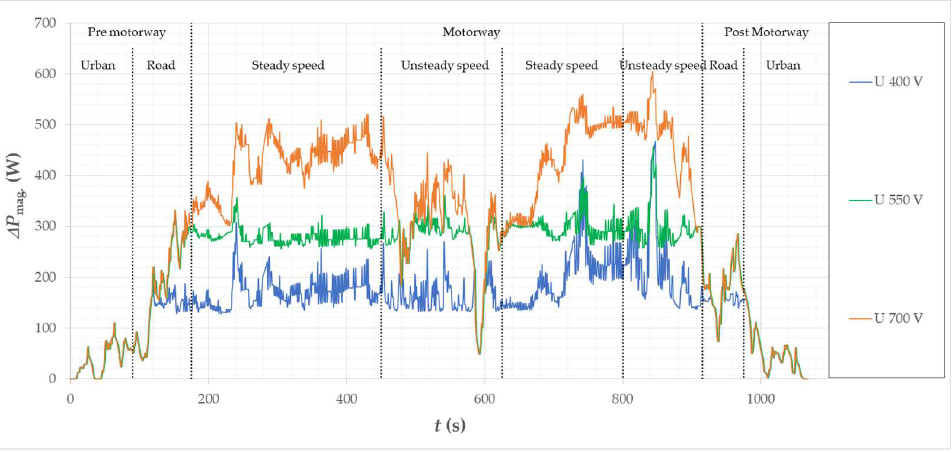
Figure 34. Calculated loss waveforms in magnets of the motor for the considered vehicle in the Artemis Motorway150 cycle .